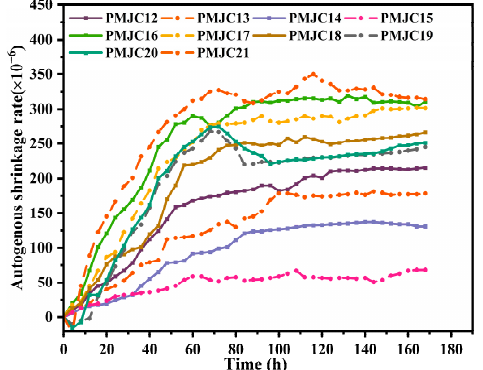
Figure 3. Tests results of the autogenous shrinkage of PMJC.